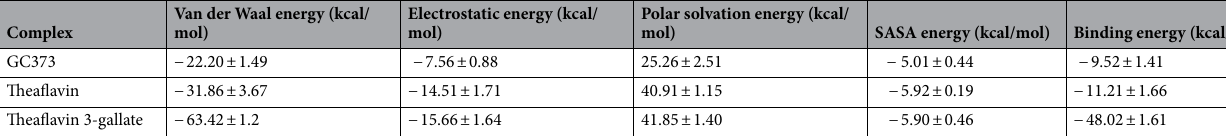
Table 2. The average values of components of the binding free energy calculated by the MMPBSA method over three simulation blocks (0–10 ns, 40–50 ns, and 90–100